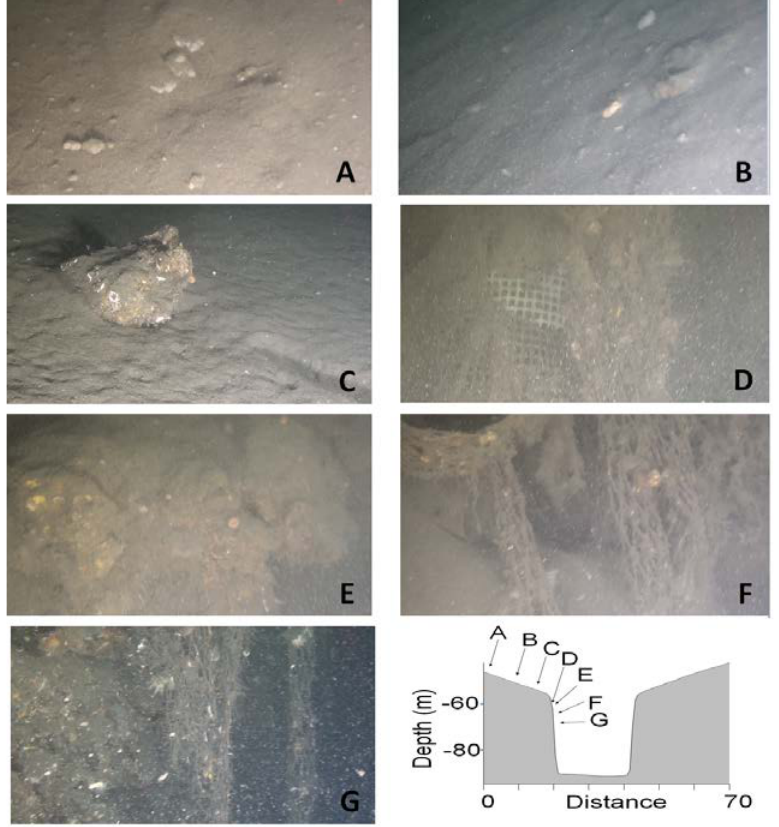
Figure 8. Images detected by Remote Operated Vehicle (ROV) inspections on the rim (A–C) and inside (D–G) the Bocca dei Pescatori morphostructure.